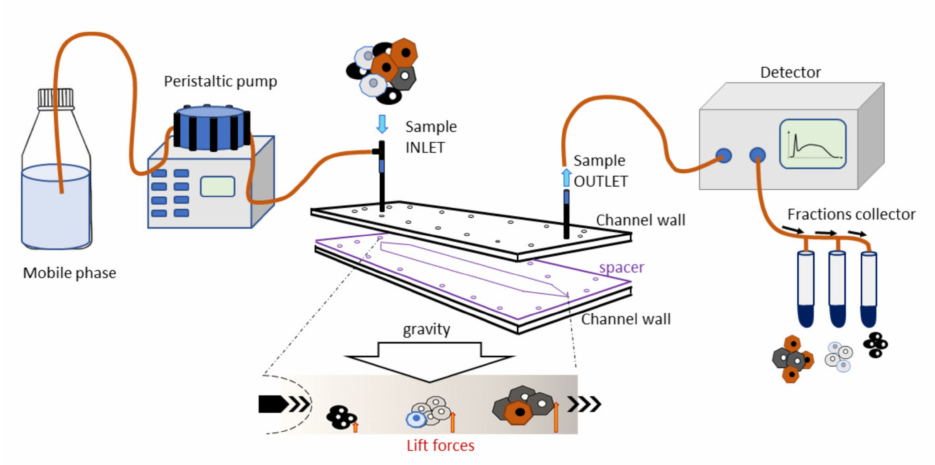
Figure 1. Graphical representation of the separation device. The separation device was connected to a peristaltic pump at the inlet and a UV detector at the outlet. Separated cells exited the detector and were collected in different tubes. Cell samples were inserted and cells, based on their physical characteristics, reached a specific position across the channel. Bigger and denser cells were the first to exit, followed by the smaller